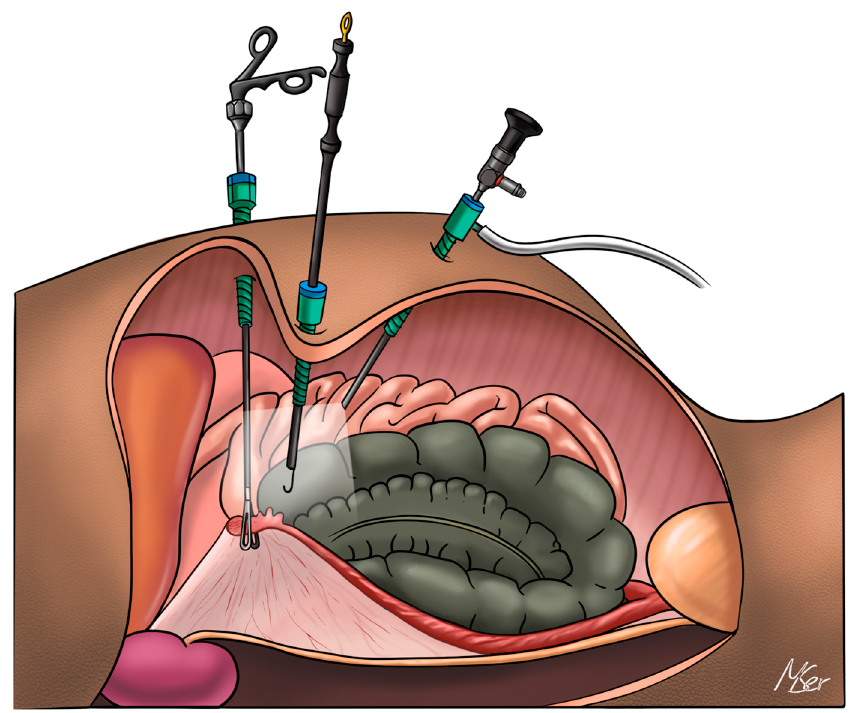
Figure 1. Instruments positioning for salpingectomy in Myocastor coypus (right lateral view).